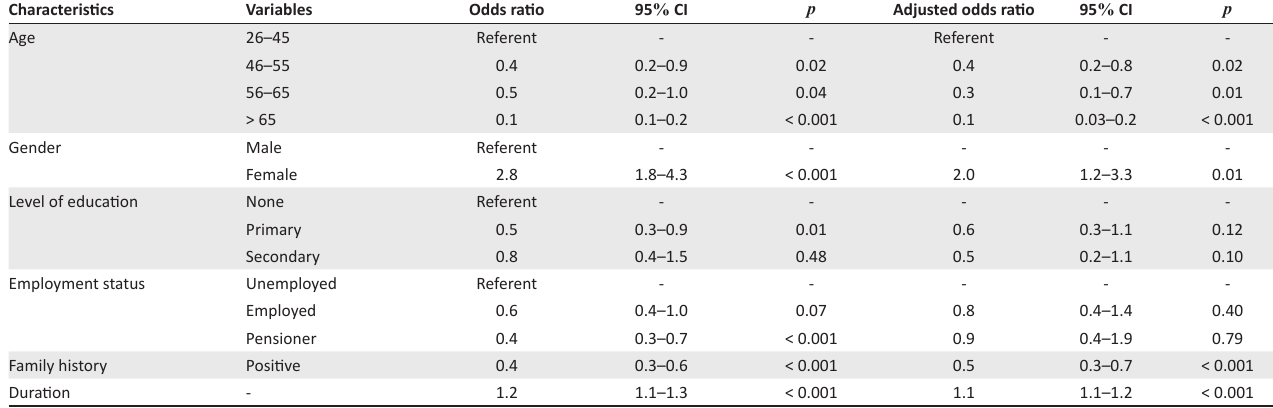
TABLE 2: Patient-related characteristics associated with their knowledge of glaucoma in the uThungulu Health District, 2016–2017. Characteristics